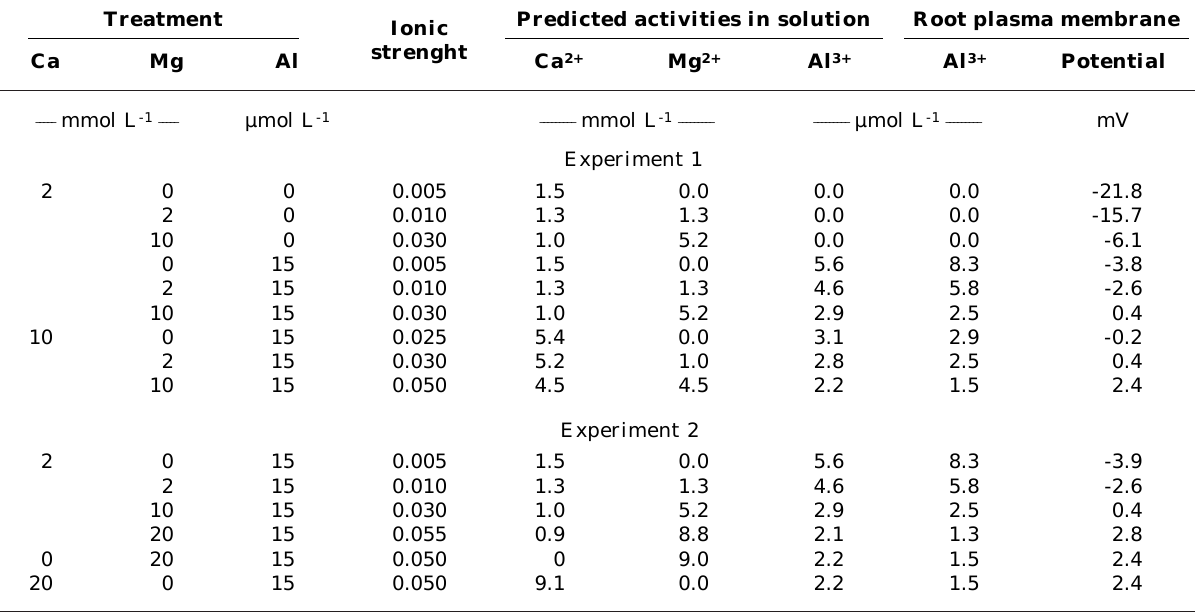
Table 1. GEOCHEM-predicted ionic strength, activities of Ca 2+ , Mg 2+ , and Al 3+ in the subsurface compartment solutions for Experiments 1 and 2, and the potential and Al 3+ activity at the root